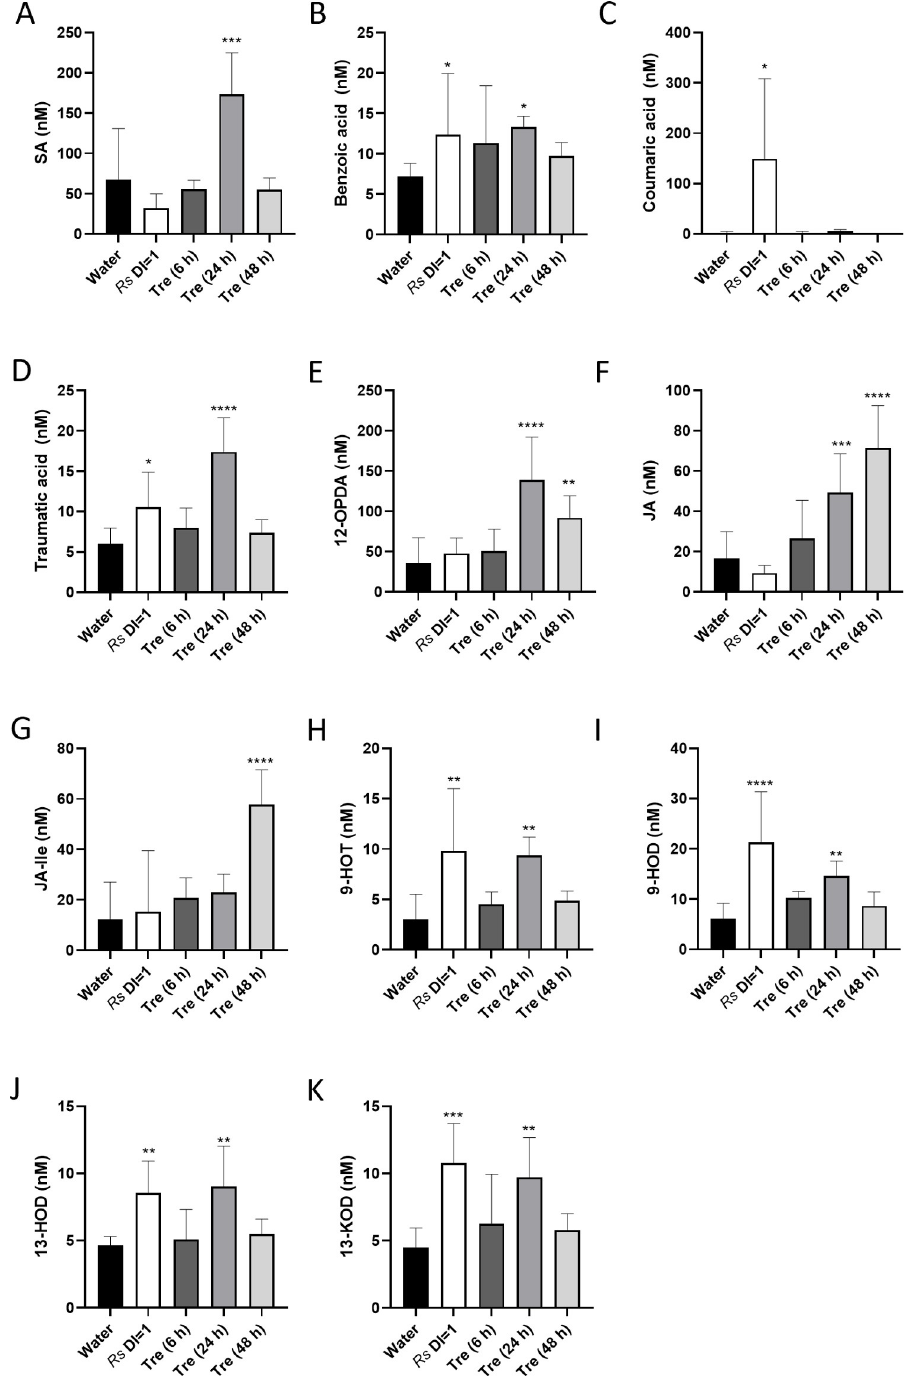
Fig 6. Trehalose treatment increased metabolites related to defense and wounding in tomato xylem sap. LC-MS/ MS determined concentrations of hormones, oxylipins, and other metabolites in xylem sap collected from cv. Bonny Best tomato plants that were mock-inoculated (H 2 O), inoculated with R . solanacearum GMI1000 when wilt symptoms first appeared ( Rs DI = 1), or had been treated at the roots with 30mM trehalose (Tre (6h), etc.) Differences from water-treated control plants were determined by one-way ANOVA Fisher’s LSD multiple comparison test: � , P = .01-.05; �� , P = .001-.01; ��� , P = .0001-.001; ���� , P < .0001. Data shown represent the means of samples from 4–6 individual plants. Bars indicate mean, vertical lines show standard deviation. A) SA = salicylic acid; B) BA = benzoic acid; C) COUMA = coumaric acid; D) TA = Traumatic acid; E) 12-OPDA = 12-oxo-8( Z ),13